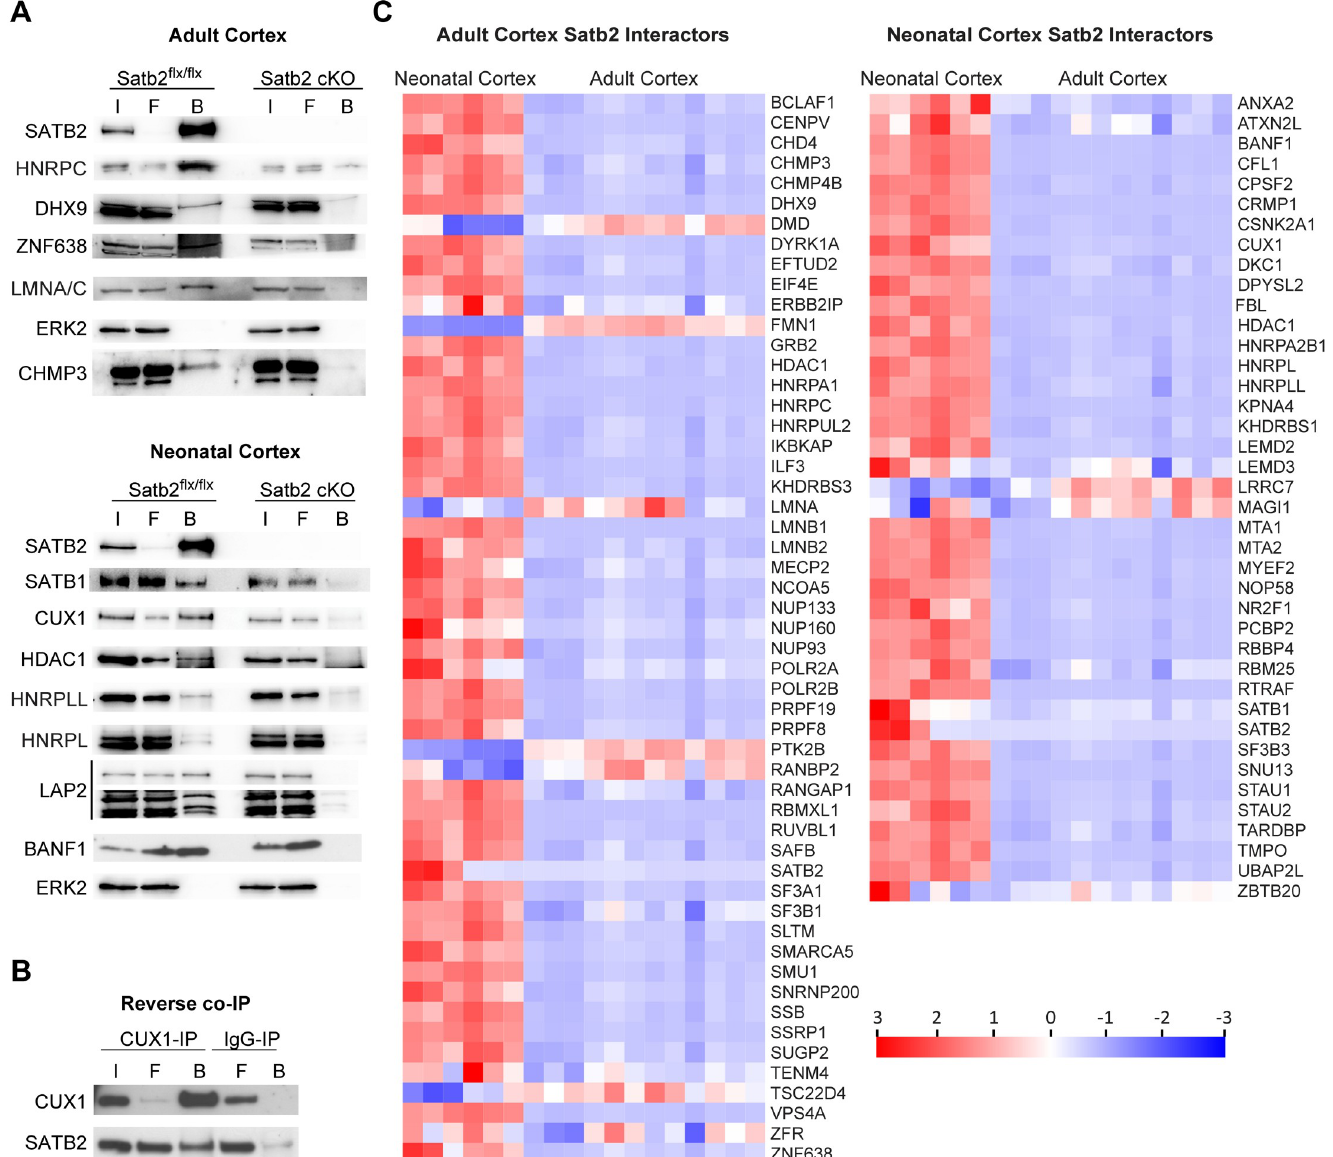
Fig 2. Validation of proteomics data. (A) Candidate SATB2 interacting proteins were strongly enriched in immunoprecipitates from cortical lysates of control but not SATB2-deficient mice by IB using the indicated antibodies. The equal input of total protein from control and SATB2-deficient cortical lysates was controlled by ERK2 detection. Representative images of the immunoblots are shown; I (Input); F (Flow-through); B (Beads). (B) Reverse IP with CUX1 and control IgG antibody, followed by IB using CUX1 and SATB2 antibodies. (C) Expression of SATB2 interactors in neonatal and adult mouse cortex. Heatmaps compare the expression levels (gene counts) of adult cortex SATB2 interactors (left) and neonatal cortex SATB2 interactors (right) in P0 vs adult mouse cortex. RNA-seq data from McKenna et al. [17] (P0 mouse cortex) and this study (adult mouse cortex) were used to generate the heatmaps by using FunRich Tool (http://www.funrich.org/). The color scale bar shows z-score values after z-score row